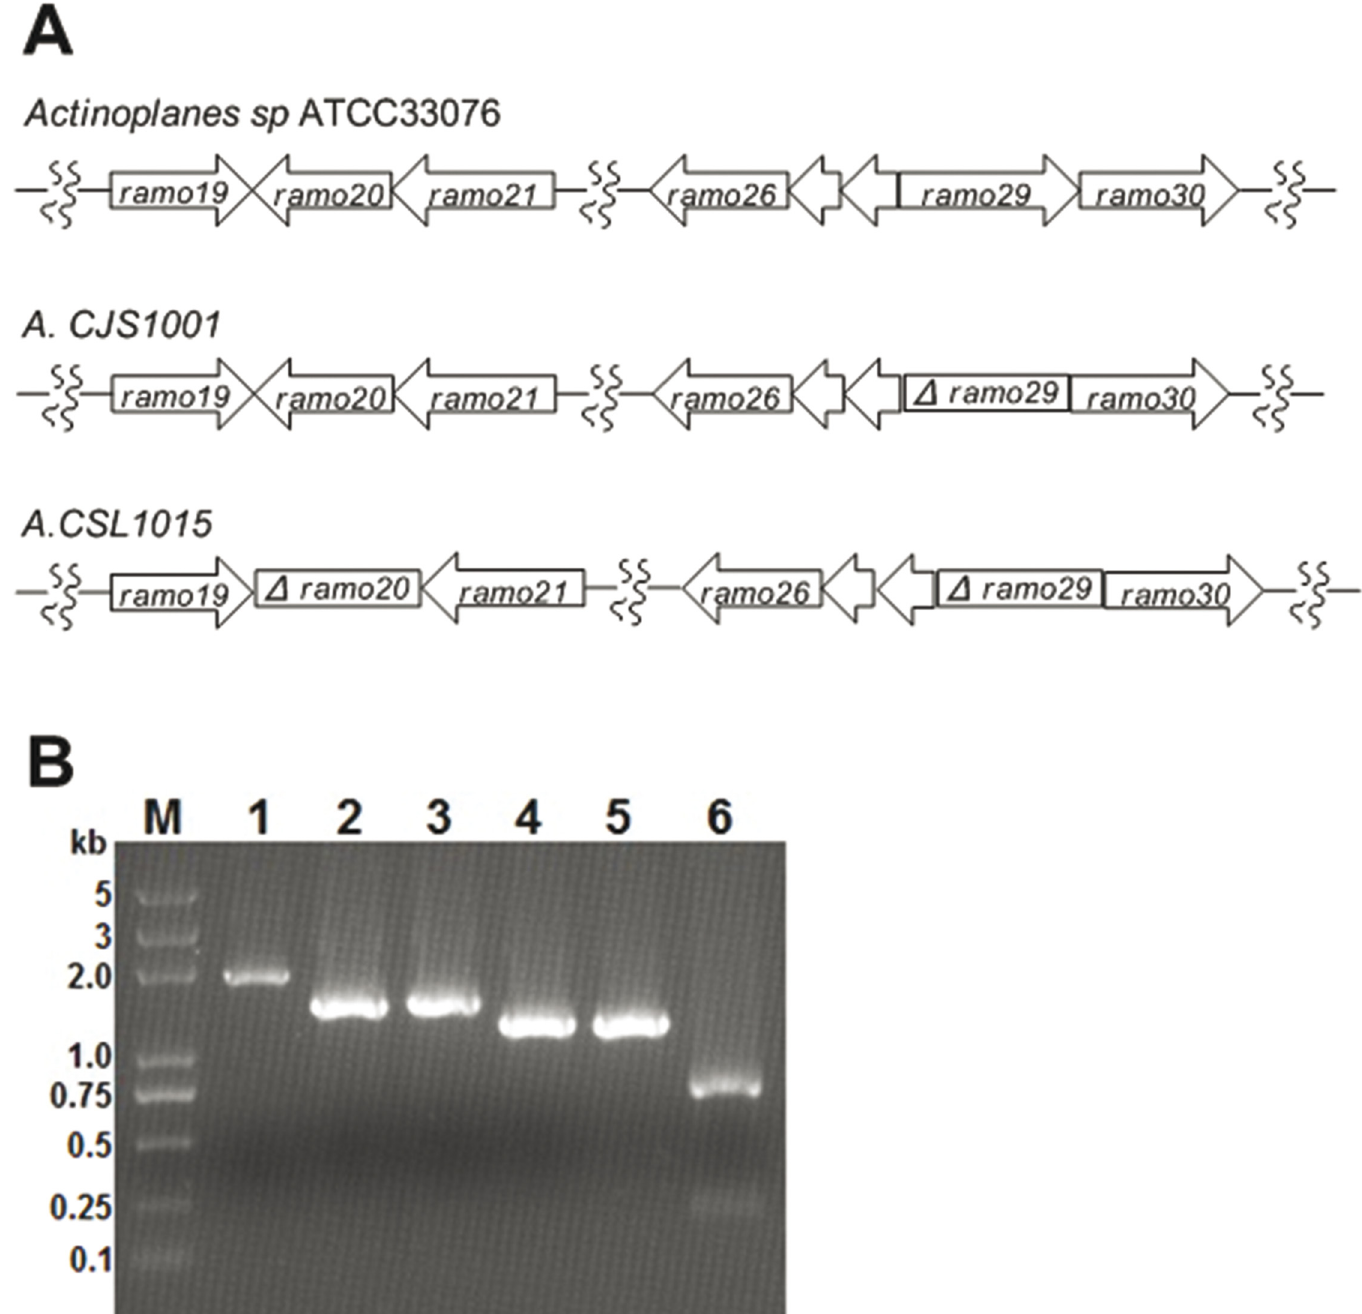
Fig 2. Genotypes of recombinant strains and PCR analysis with the genomic DNA from Actinoplanes sp . ATCC33076 and its mutation as the template. (A) Genotypes of ATCC33076 and its mutants; (B) Using 5 ’ - ATGGATGTCCCGAGGGTG -3 ’ and 5 ’ - TCAGGGCTTGTCGCATCG -3 ’ as primers, ram29 in-frame deletion PCR analysis of recombinant strains confirmed that they have the designed genotypes that the double-crossover homologous recombination event took place: 1.8 kb ( lane 1 ) for wild type, 1.4 kb ( lane 2 ) for A . CJS1001 , and 1.4 kb ( lane 3 ) for A . CSL1015 . Using 5 ’ -ATCTCGCTG AGCACGGTGAAGG-3 ’ and 5 ’ - TGCACGCCGGAGGAGAACAC -3 ’ as primers, ram20 in-frame deletion PCR analysis of recombinant strains confirmed that they have the designed genotypes that the double-crossover homologous recombination event took place: 1.2 kb ( lane 4 ) for wild type, 1.2 kb ( lane 5 ) for A . CJS1001 , and 0.75kb ( lane 6 ) for A . CSL1015 .